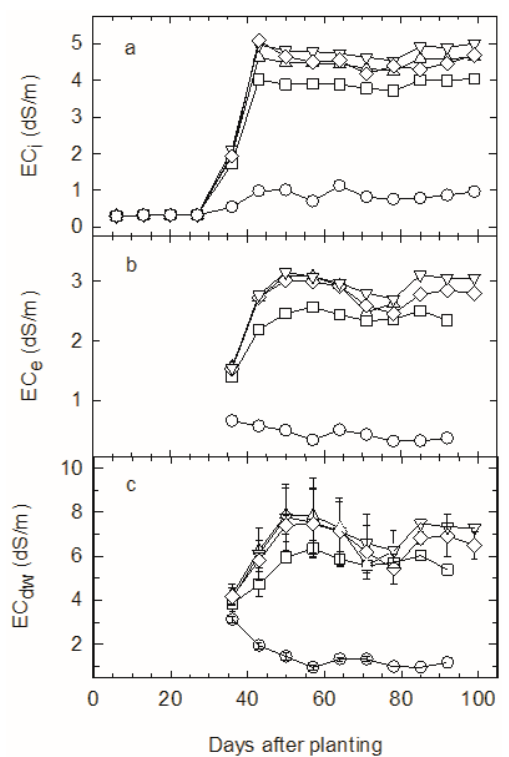
Figure 1. The temporal variation in the salinity of irrigation water (EC i ) ( a ), soil (EC e ) ( b ) and drainage water (EC dw ) ( c ). In ( c ), vertical bars represent the standard error; absence of the SE bar indicates that the value is based on one rather than two datum points. CONT ○ , 85%SALT ◊ , SALT + 7.5%F ∇ , SALT + 15%F Δ , SALT + 22.5%F □ .